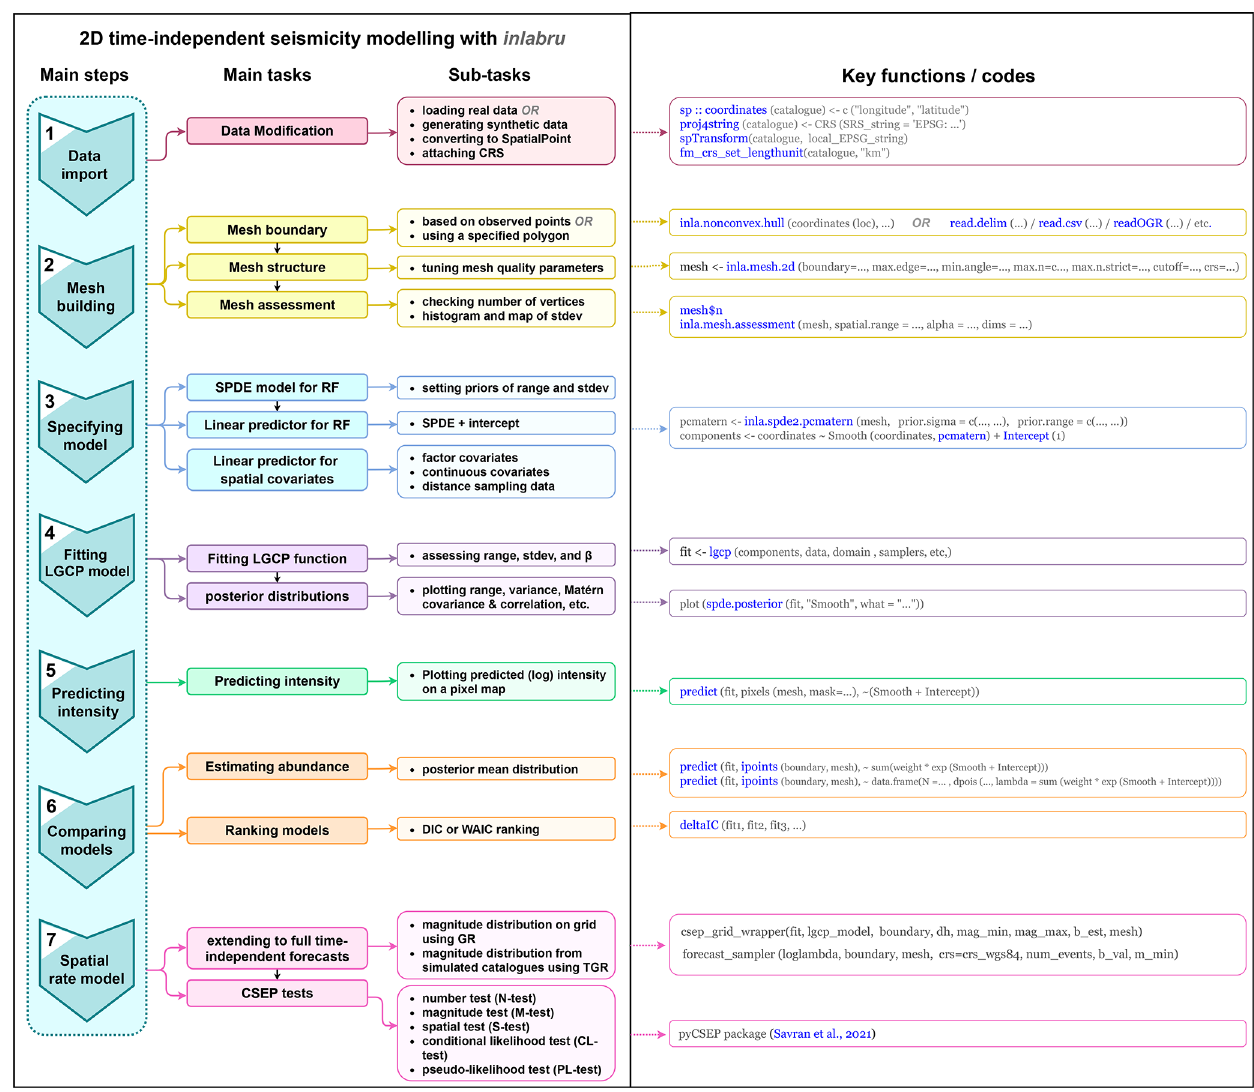
Figure 1. The workflow for generating spatial seismicity models in inlabru, with functions shown on the right.